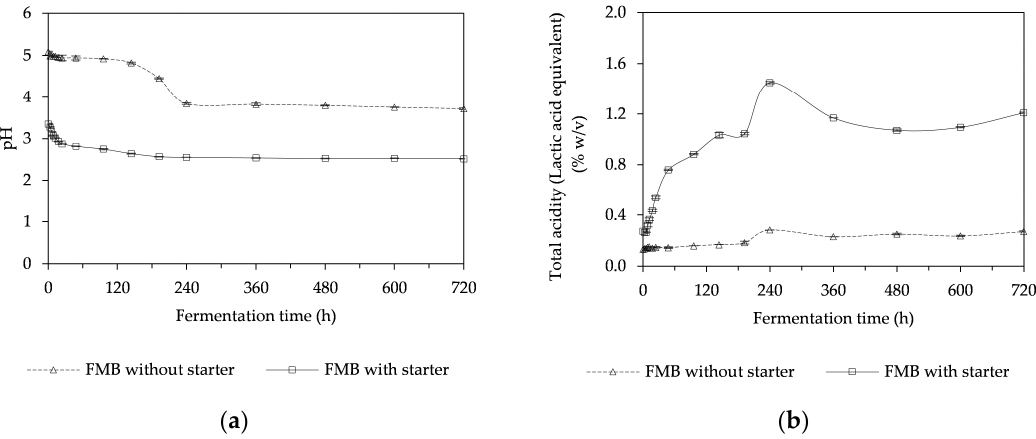
Figure 3. The change of acidity in a fermented mushroom beverage (FMB) with and without starter culture L. plantarum SK15 during fermentation time: ( a ) pH; ( b ) total acidity as the percentage of lactic acid equivalent.